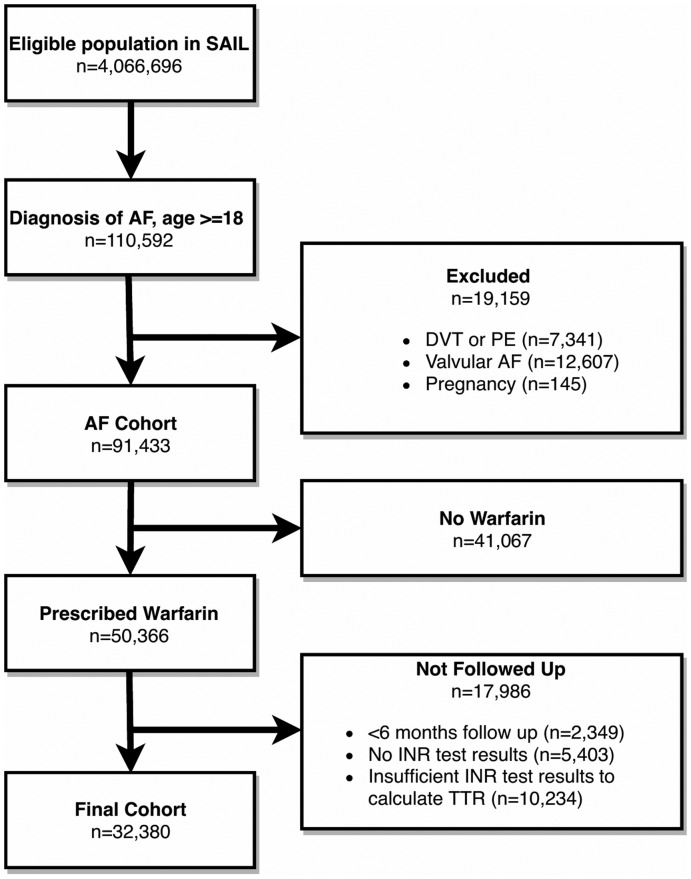
Inclusion criteria for study cohort.